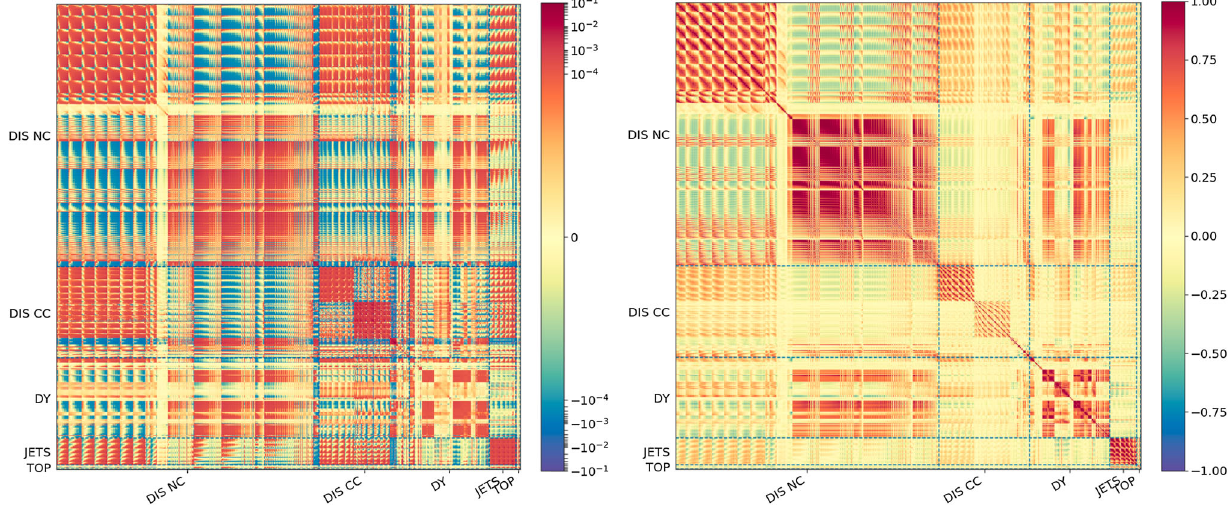
Fig. 2 The covariance matrix of PDF uncertainties, X ij , nor- malized to the theoretical predictions T responding correlation matrix X ij /